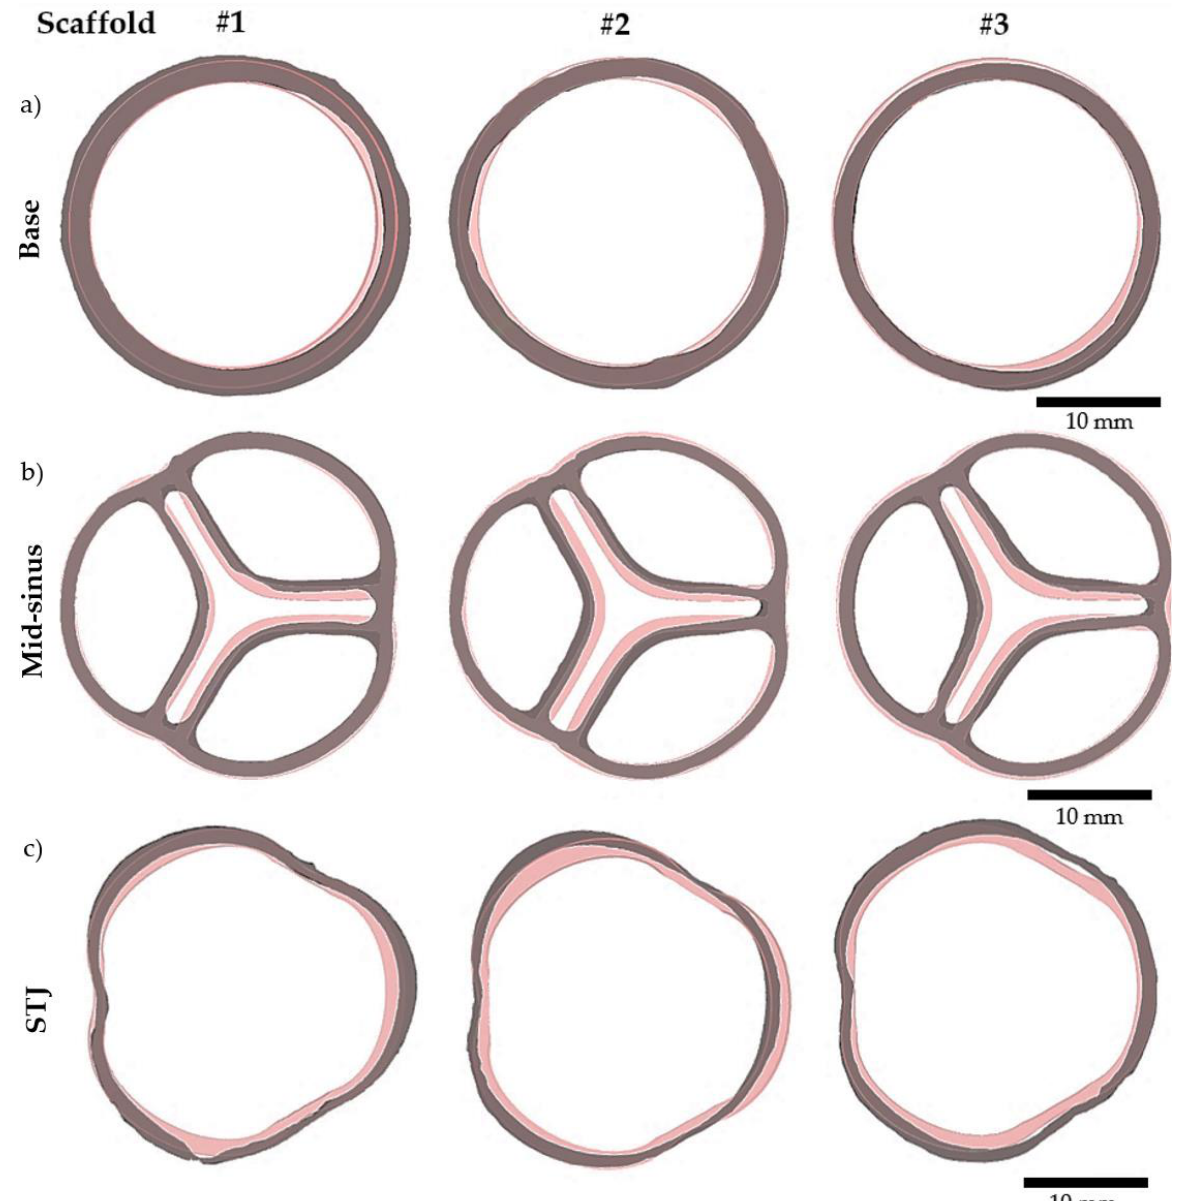
Figure 6. Three aortic valve scaffolds were compared to the original computer-designed model. Images generated after 3D reconstruction of micro-CT scans of n = 3 scaffolds are shown in grey. The original computer-designed model to which a uniform contraction of 13% was imposed is shown in pink. ( a ) Base slices. ( b ) Mid-sinus slices. ( c ) STJ (sino tubular junction) slices.